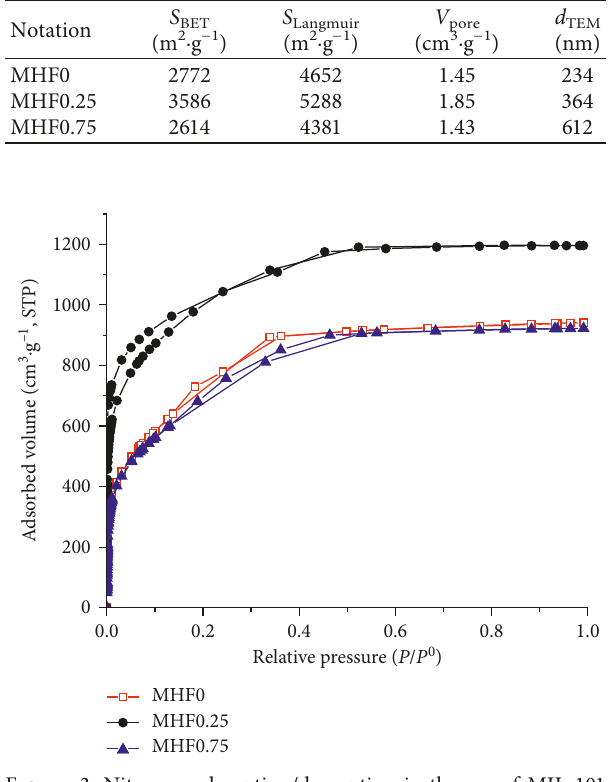
Figure 3: Nitrogen adsorption/desorption isotherms of MIL-101 synthesized with different molar ratios of HF/H 2